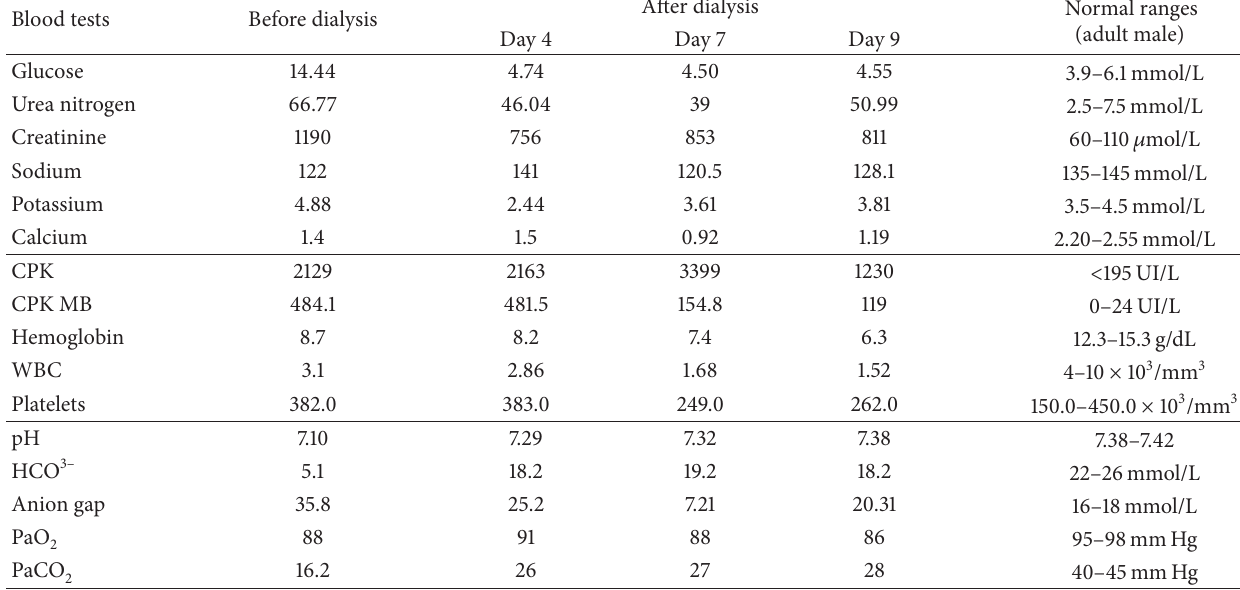
Table 1: Biochemical, hematologic, and blood gas parameters, before and after